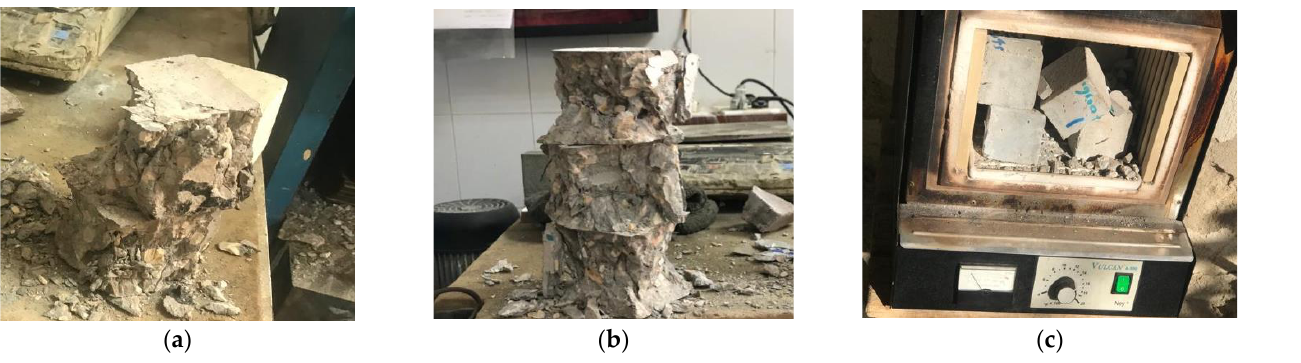
Figure 6. Compressive failure modes for specimens exposed to temperatures up to 600 °C for ( a ) Mono fiber reinforced concrete specimens, ( b ) Hybrid fiber reinforced concrete specimens, ( c ) Con- trol